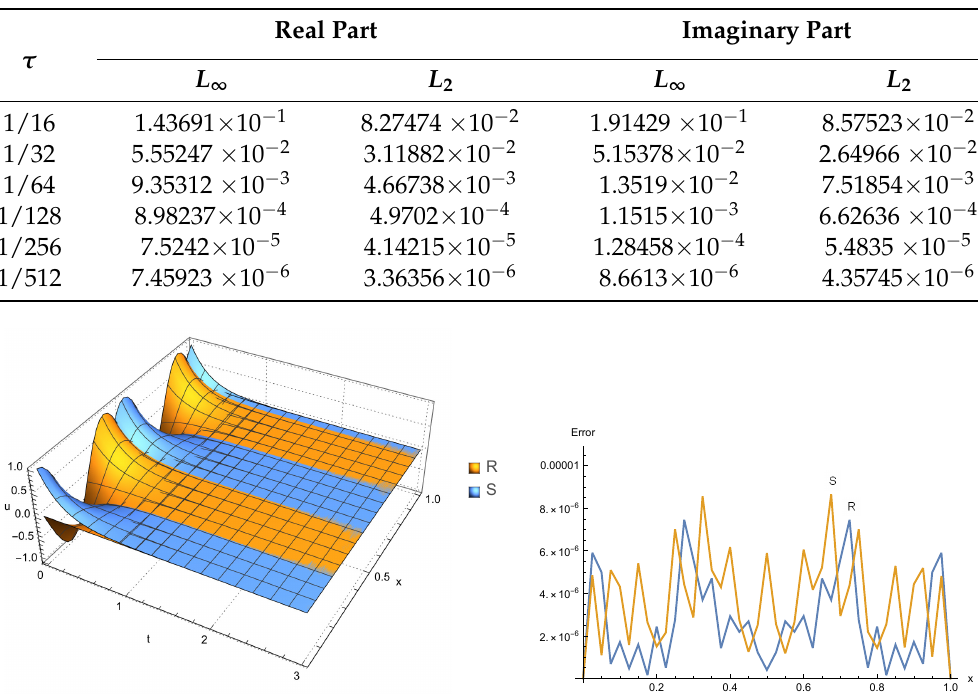
Table 10. Error norms of real and imaginary parts of Equation (3) for different choices of τ at N = 40, α = 0.5, t = 3.